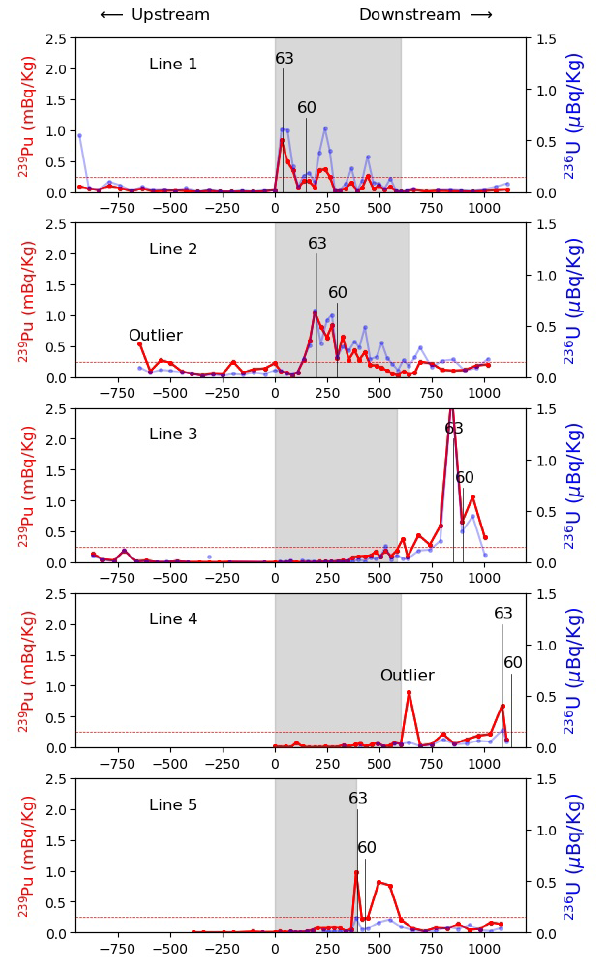
Figure 6. Activities of 239 Pu and 236 U along the five sampled lines as defined in Fig. 5 from upstream to downstream. The shaded area correspond to the region sampled in high resolution (i.e., ≈ 25m instead of ≈ 50m). The vertical line depicts the position where ice from 1960 and 1963 have been identified ( ± 2 or ± 6 . 5 years). The threshold 0.25mBqkg − 1 used to qualify contaminated samples in Fig. 5 is indicated by a dashed horizontal line. Note that the uncer- tainty associated with 239 Pu measurement is less than 4% for all samples that are above 0.1mBqkg − 1